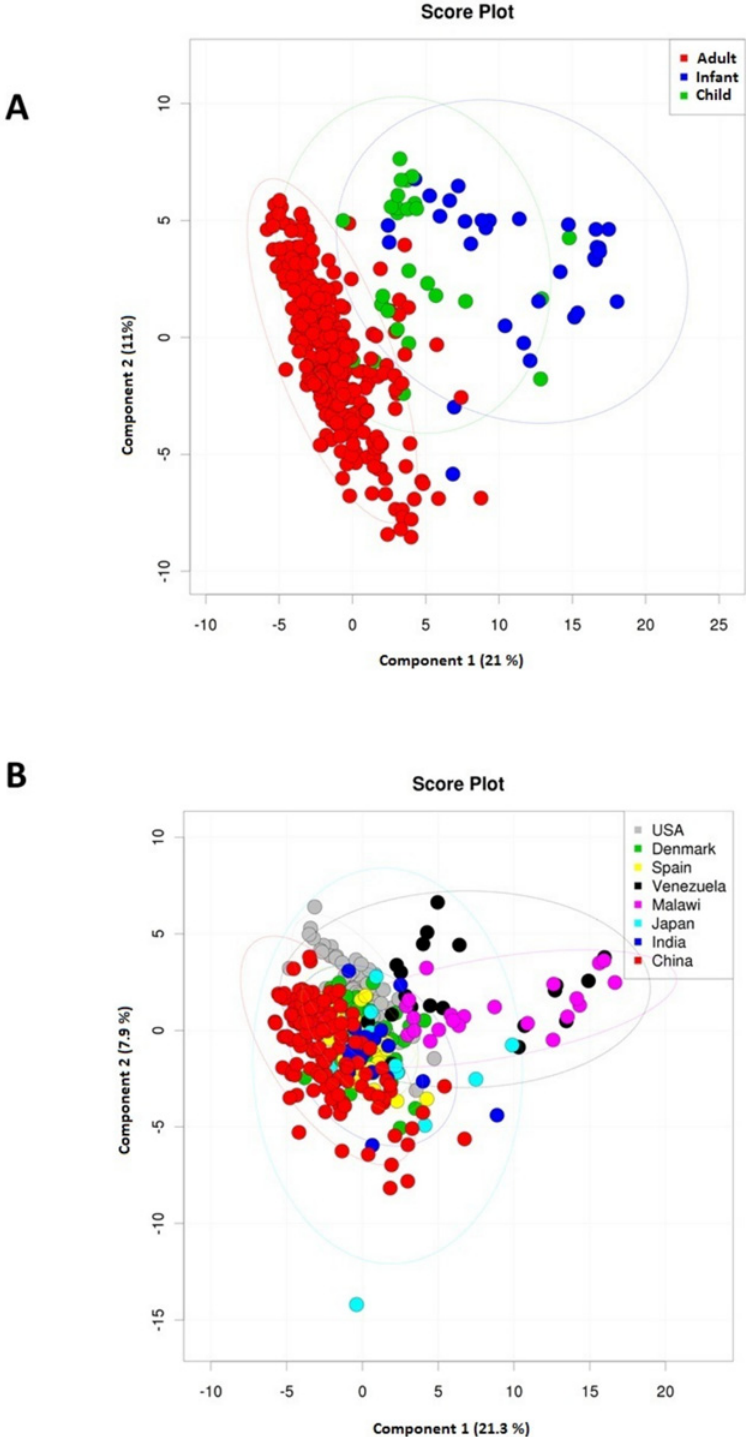
Fig 1. Differential CAZyme profiles across age and geographies. Partial Least Square Discriminant Analysis (PLS-DA) score plots showing global profiles of CAZymes across (a) Age and, (b) Geography. While there is a clear distinction in the CAZyme profiles of children/infants as compared to adult individuals, the differences among the adult individuals of various geographies are relatively subtle. However these differences are with respect to the overall CAZyme